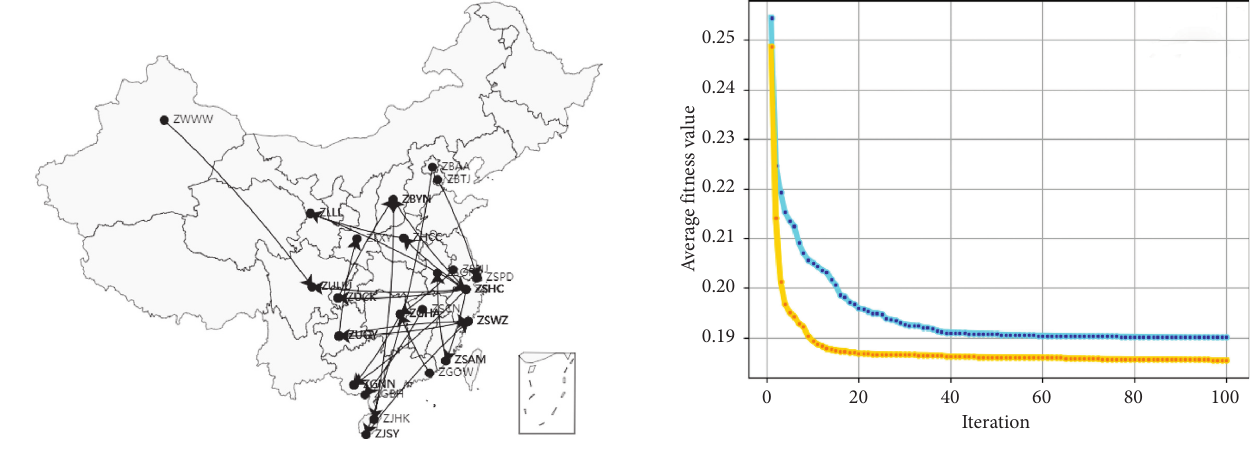
Figure 5: Flight routes of block time with more than 6 airlines applying for the adjustment.